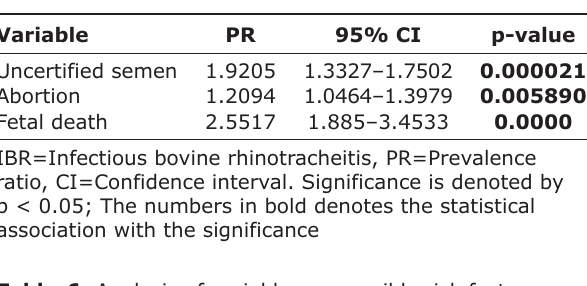
Table-6: Analysis of variables as possible risk factors associated with IBR infections.